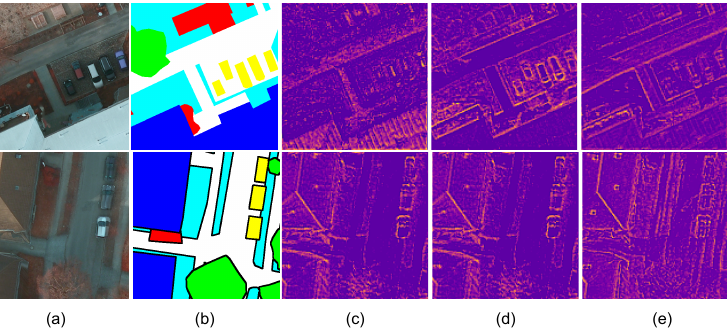
Figure 2. Visualization of several low . feat maps. ( a , b ) are the image and corresponding ground truth, respectively. ( c – e ) demonstrate several corresponding low . feat maps.